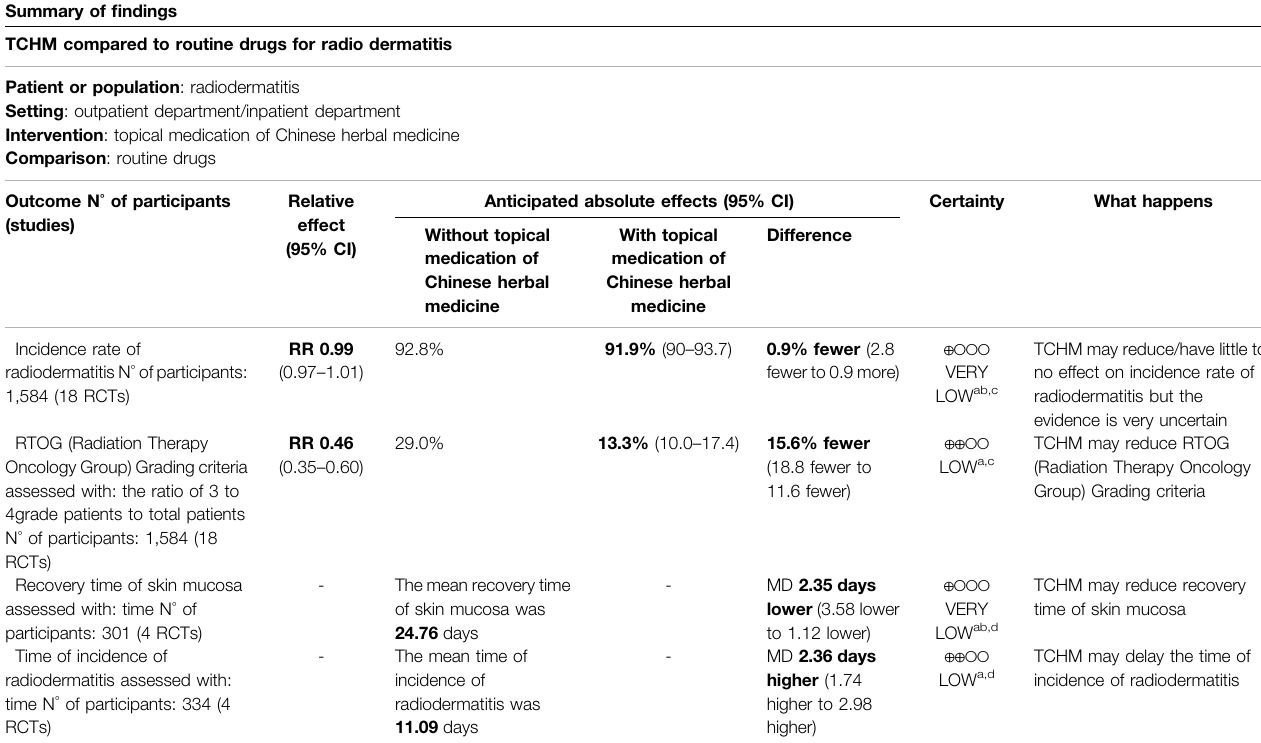
TABLE 3 | Summary of fi nding table of TCHM compared to routine drugs for radiodermatitis. Summary of fi ndings TCHM compared to routine drugs for radio dermatitis Patient or population : radiodermatitis Setting : outpatient department/inpatient department Intervention : topical medication of Chinese herbal medicine Comparison : routine drugs Outcome N ° of participants